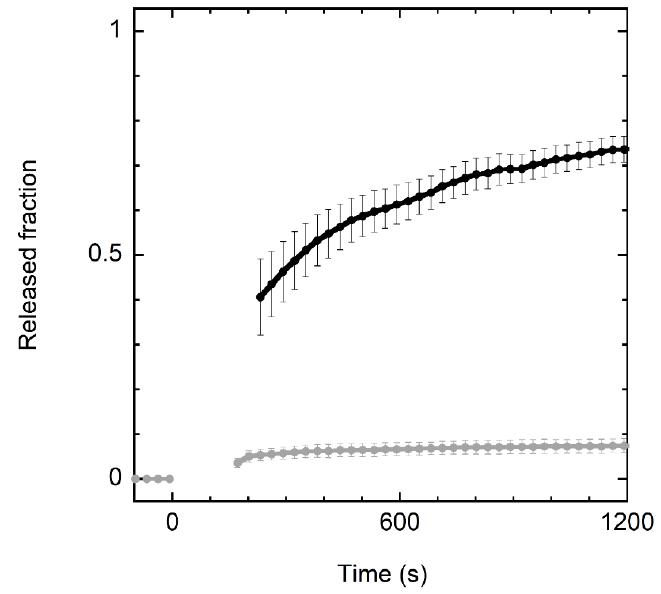
Figure 1. Kinetics of CF release from vesicles after addition of crabrolin21. Kinetics of CF release after addition of crabrolin21 to POPE/POPG (7:3 molar ratio) or POPC/cholesterol vesicles (1:1 molar ratio) (black and gray lines, respectively). Liposome concentrat ion: 50 μM . Crabrolin21 concentra- tion: 1.5 μM. Measurements were performed at 298 K and pH 7.4. Standard errors over three meas- urements are reported.